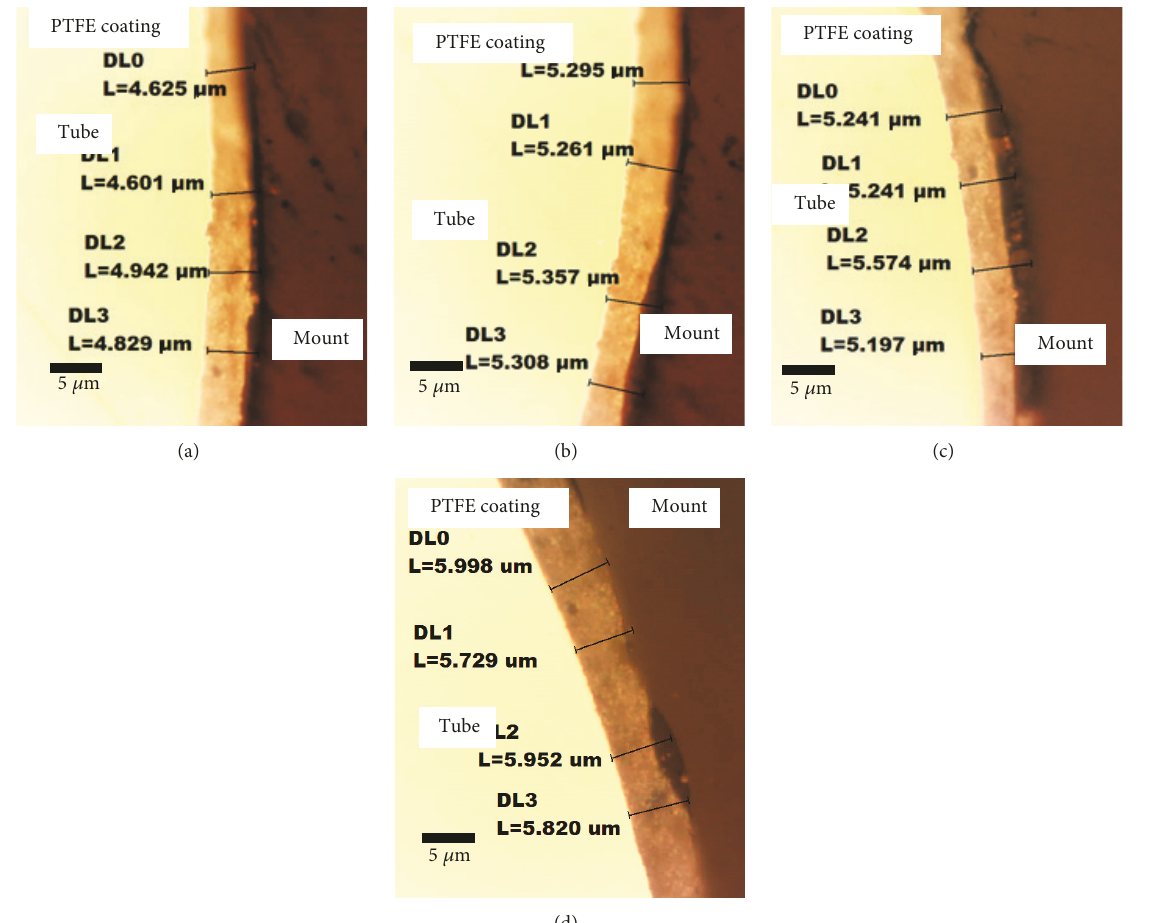
Figure 3: Optical micrographs of the cross-sectional area of the sample at different immersion times: (a) 10s and (b) 20 s (viscosity of 900 mPa ⋅ s, withdrawal rate of 20 mm/s, and spin speed of 100 rpm) and (c) 10s and (d) 20 s (viscosity of 900 mPa ⋅ s, withdrawal rate of 25 mm/s, and spin speed of 100rpm).